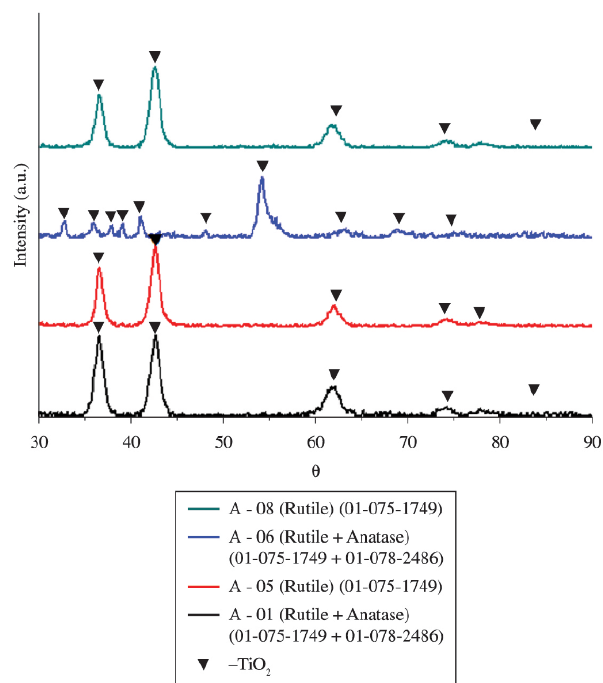
Figure 5. X-Ray diffractogram in rasante incidente of deposited glass sample with double titanium cage at 350° C, where sample A – 01 and A – 05 were the treatment time lasted 4 e 6h, respectively and a gaseous mixture of 06 sccm H A – 06 and A – 08 had their treatment time lasted 4 e 6h respectively, with a gaseous mixture of 09 sccm H